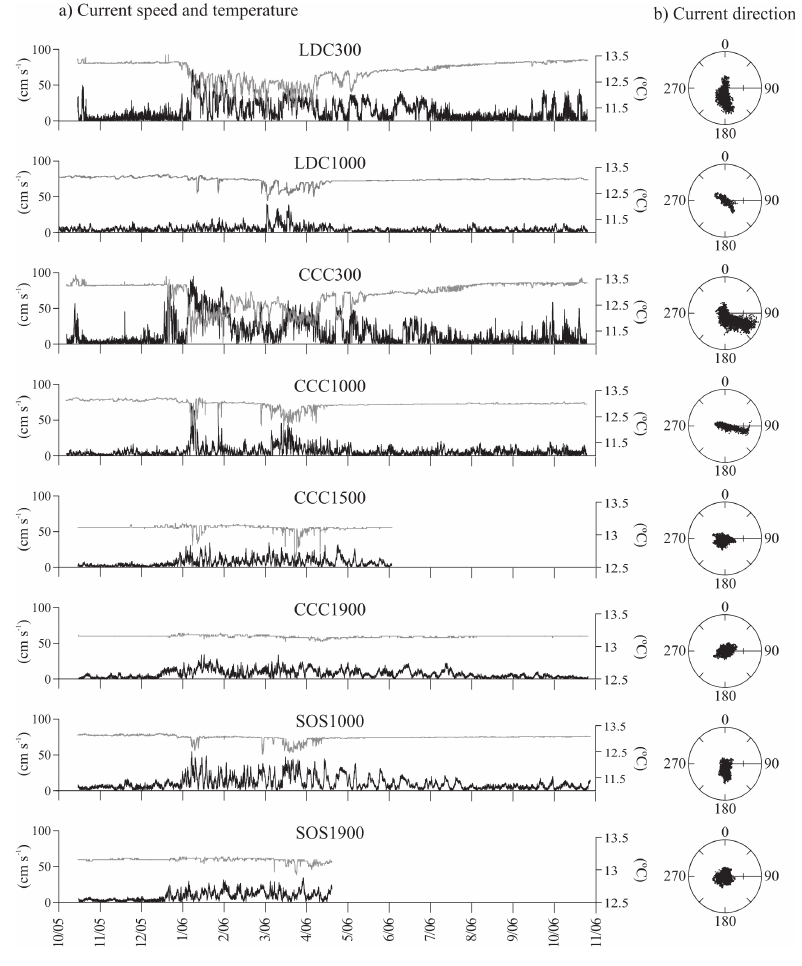
Fig. 3. (a) Current speed (cms − 1 ) and temperature ( ◦ C) and (b) current directions as a function of the speed (radius limits are 0–100cms − 1 ) recorded at 5mab at each station location (note different temperature axis